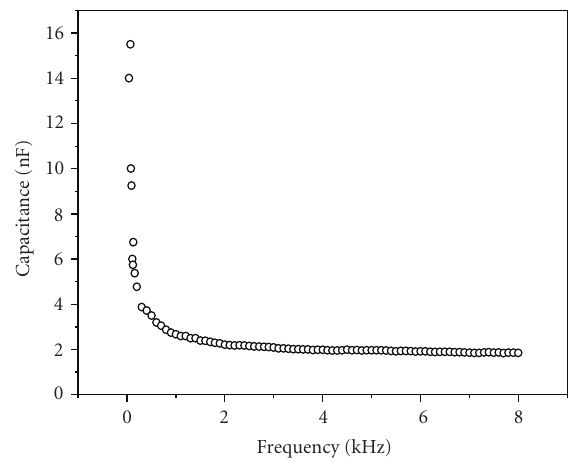
Figure 6: Capacitance-Frequency characteristics of ITO/PANI-co- POT/Al